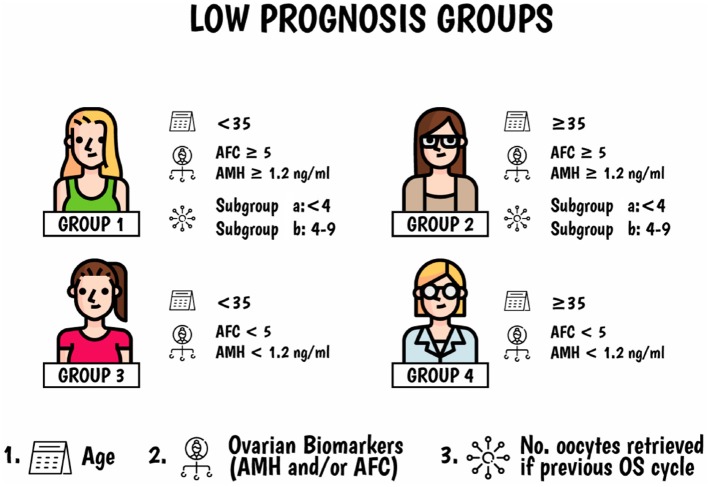
Poseidon criteria of low prognosis patients in ART. Four distinct groups of low prognosis patients can be established based on quantitative and qualitative parameters, namely: 1. The age of the patient and the expected embryo aneuploidy rate; 2. Ovarian biomarkers (antral follicle count [AFC] and/or anti-Müllerian hormone [AMH]), and 3. The ovarian response of the patient in terms of oocyte quantity provided a previous cycle of stimulation was carried out. Art drawing by Chloé Xilinas, EXCEMED, Rome, Italy. Adapted from Esteves et al. (10).